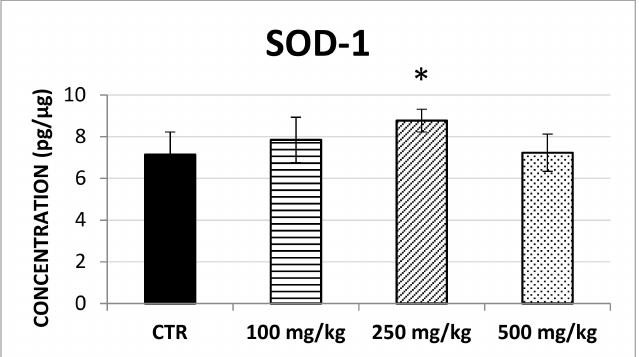
Figure 4. The average SOD-1 concentration in the control group and in mice treated with different dosages of propolis expressed in pg/mg of soluble liver protein. A significant difference could be detected after the prolonged treatment, with 250 mg/kg of propolis extract compared to the control (* means a p = 0.0106).